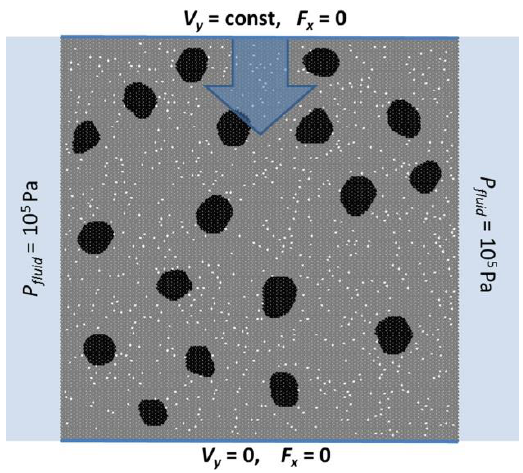
Figure 2. Schematic of uniaxial compression of concrete sample.